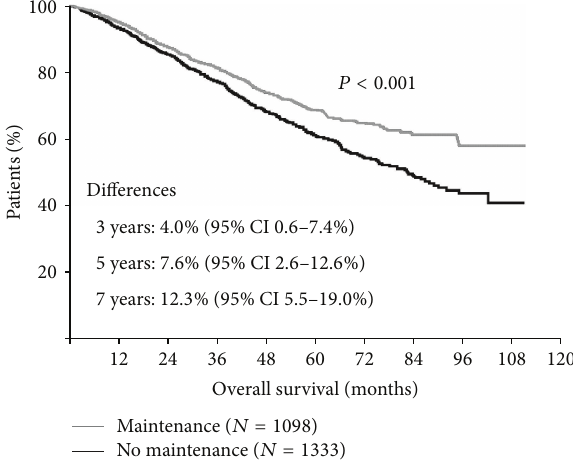
Figure 3: Meta-analysis of thalidomide maintenance showing OS benefit (adapted from